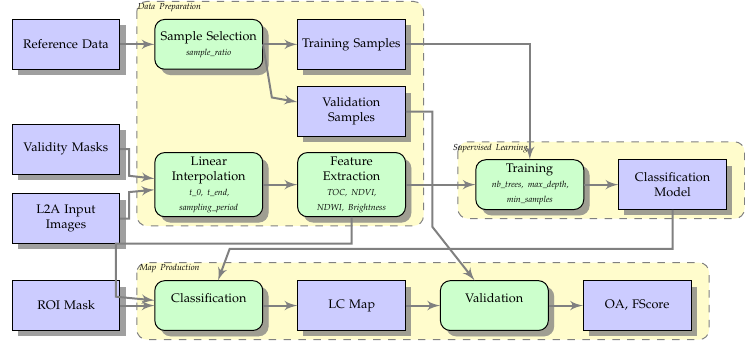
Figure 3. Block diagram of the land cover map production